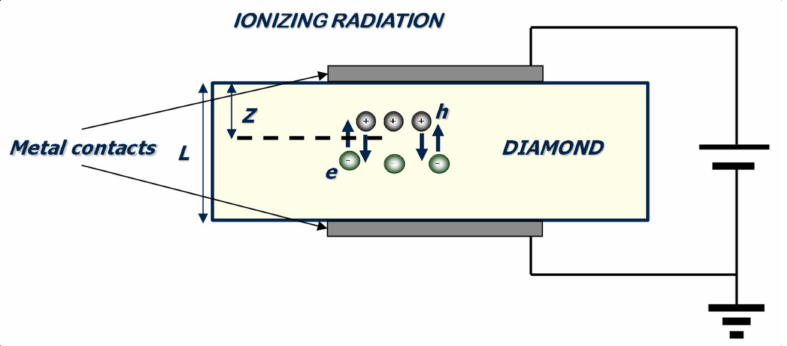
Figure 5. Schematic view of a typical diamond